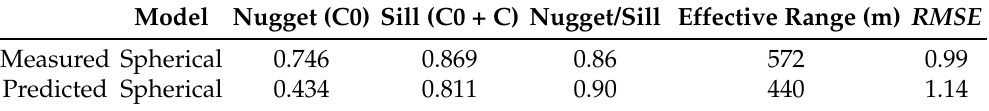
Table 5. Parameters of an ordinary kriging semi-variogram model for Cr concentration.